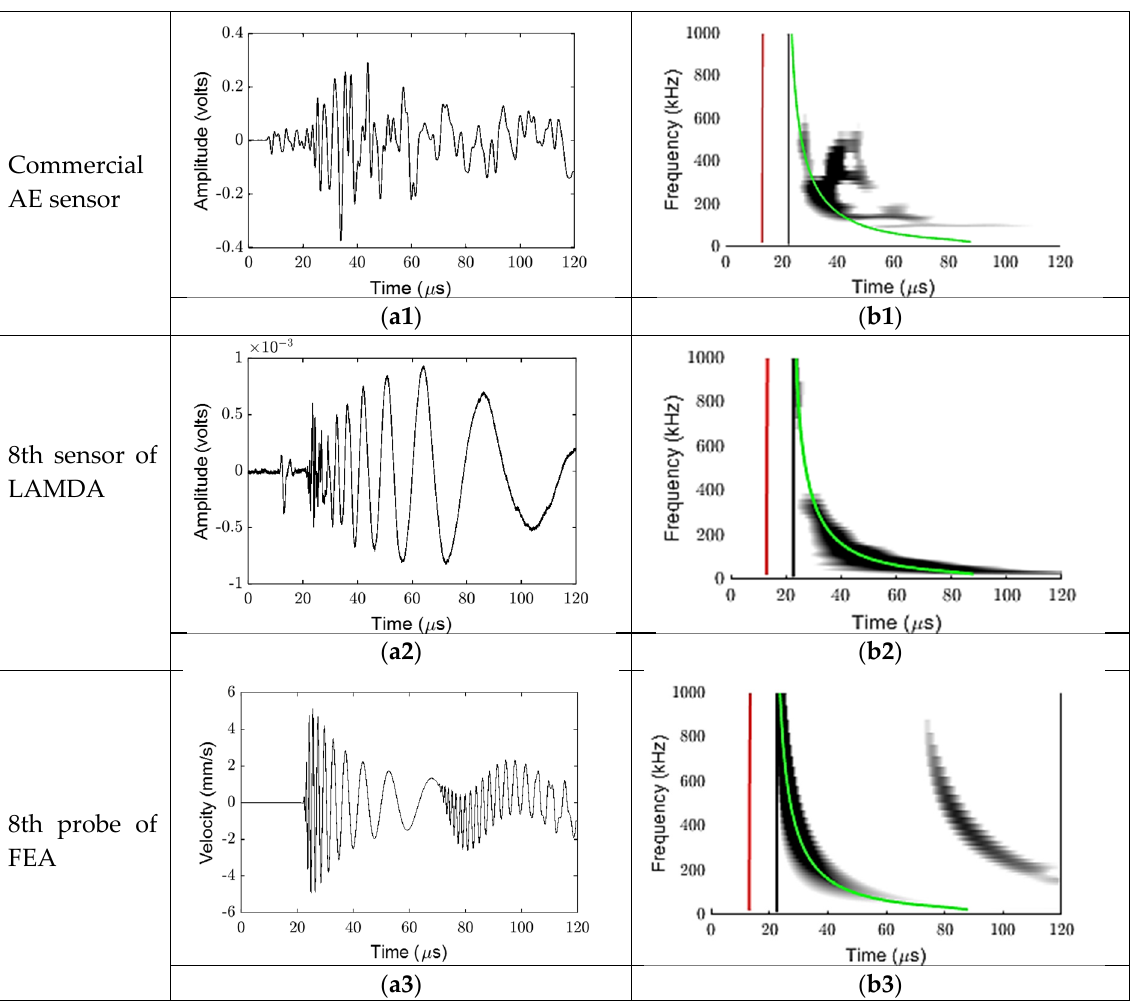
Figure 5. Transverse PLB results. Top row shows waveform ( left ) and corresponding time–frequency plot ( right ) for commercial AE sensor. Middle row as for top row but for LAMDA sensor. Bottom row as for top row but for FEA prediction corresponding to out-of-plane velocity